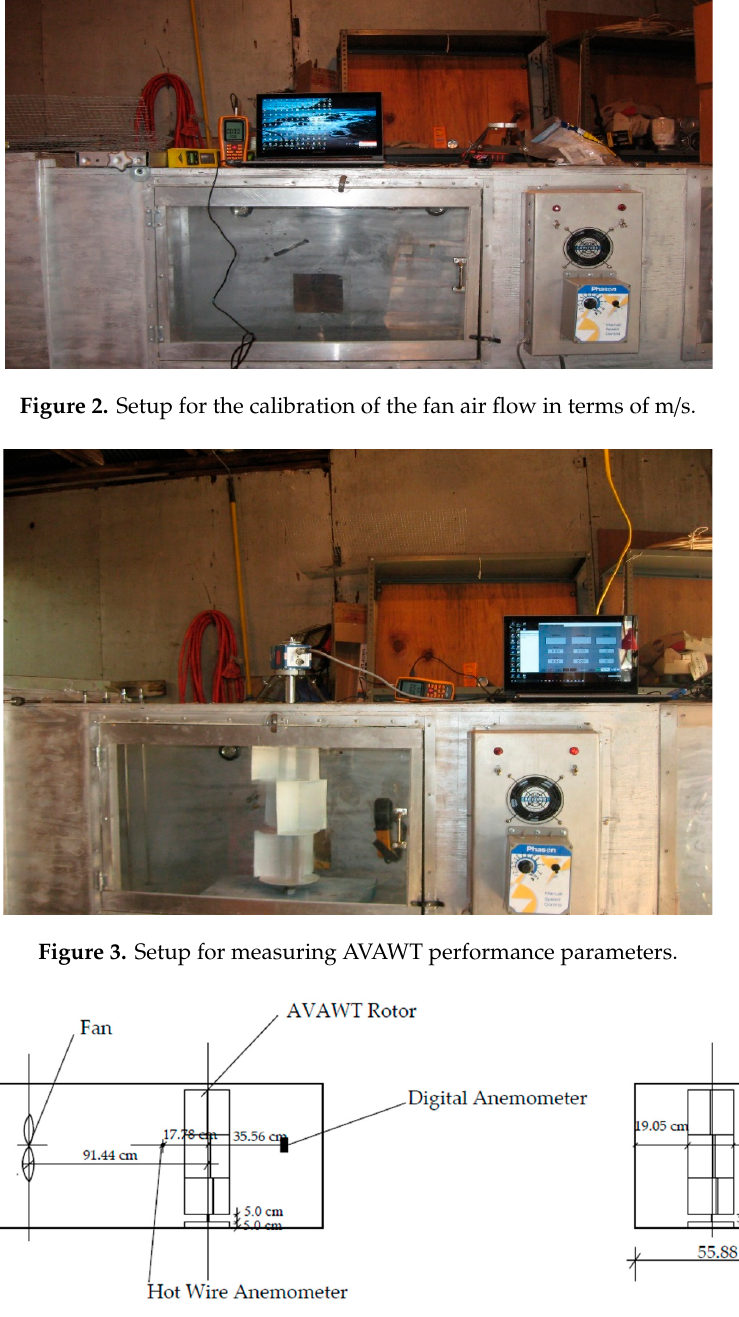
Figure 4. Experimental setup showing measurements.